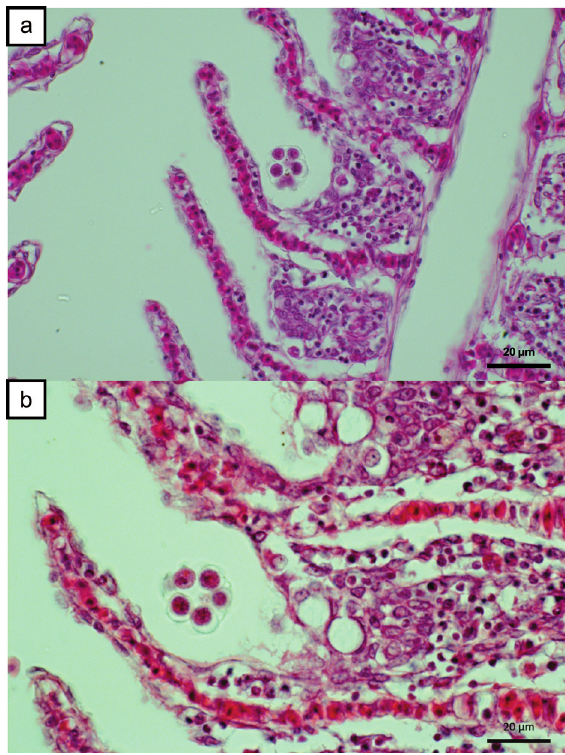
Figure 2 - a. Transmission electron Microscopy of Dermocystidium spores showing the structures. V – vacuole; G – Golgi-complex; N – nucleus; M – mitochondria. (bar = 1 μm). b. Transmission electron Microscopy of Dermocystidium spores showing the hyaline cytoplasm (bar = 2